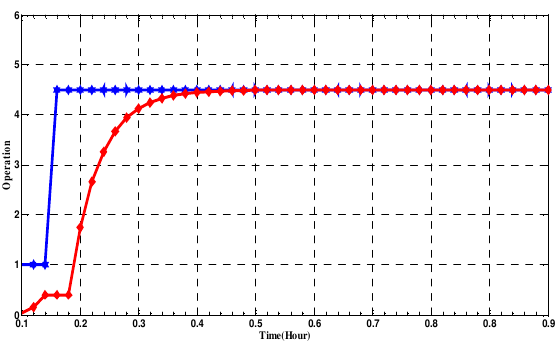
Fig. 5. The normal operation of the ESP cement